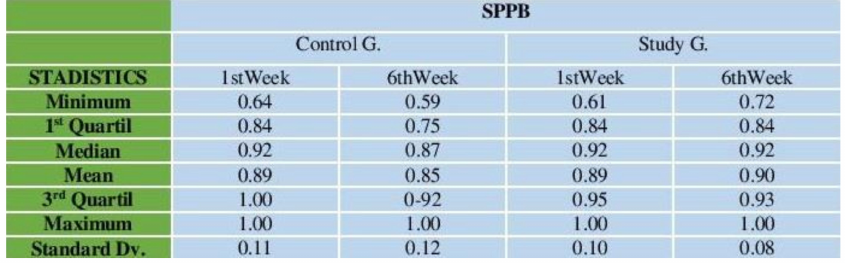
Figure 5. Statistical description of SPPB results in the first and sixth weeks of the study.